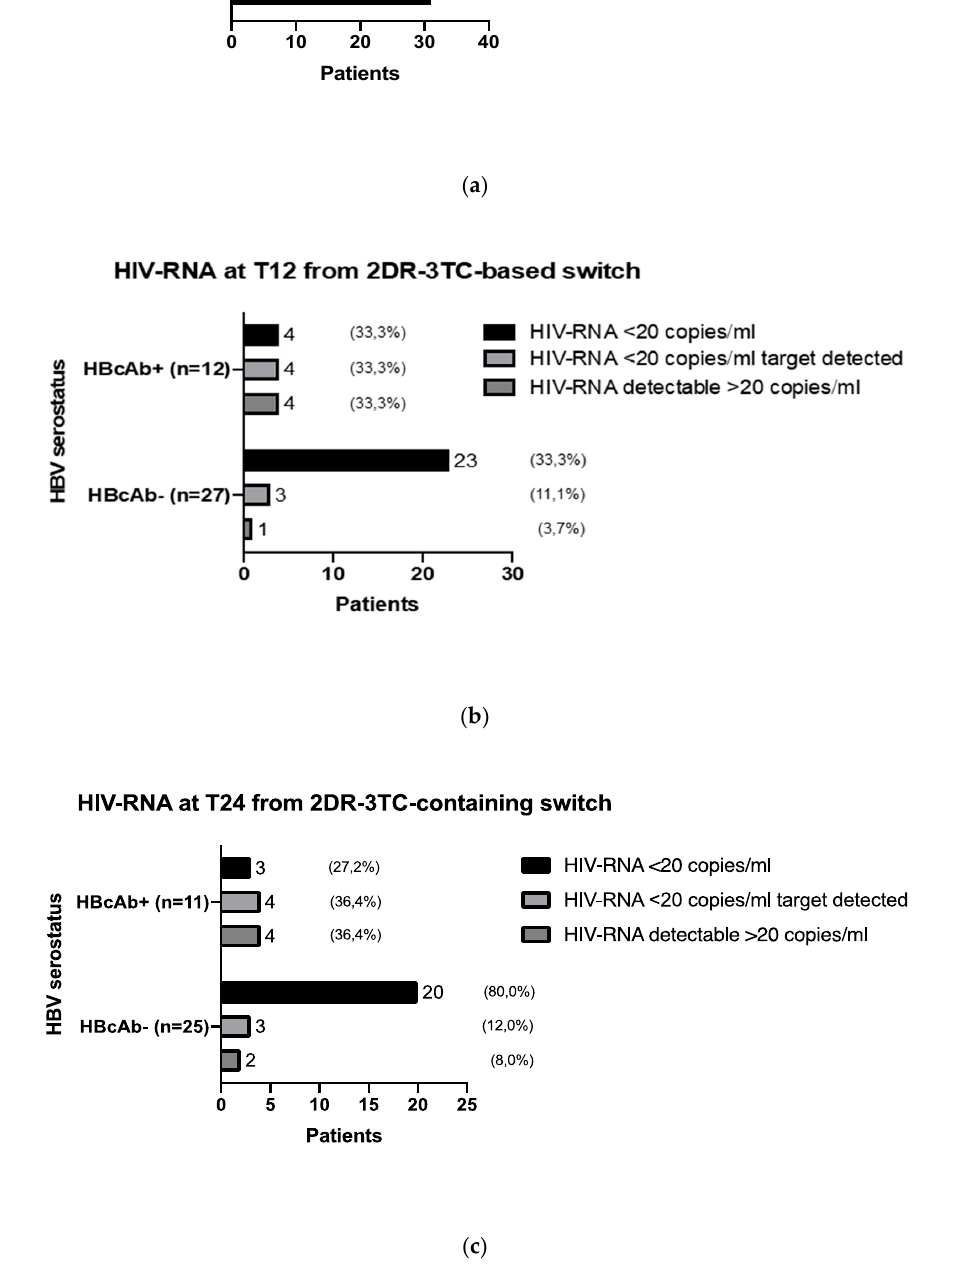
Figure 2. Comparison of HIV-RNA undetectability after the 2DR-3TC switch in the HBcAb-positive and HBcAb-negative groups, after 6 months ( a ) T6, n = 46, 12 months, ( b ) T12, n = 39, and 24 months ( c ) T24, n = 36, and overall comparison of patients subgroup